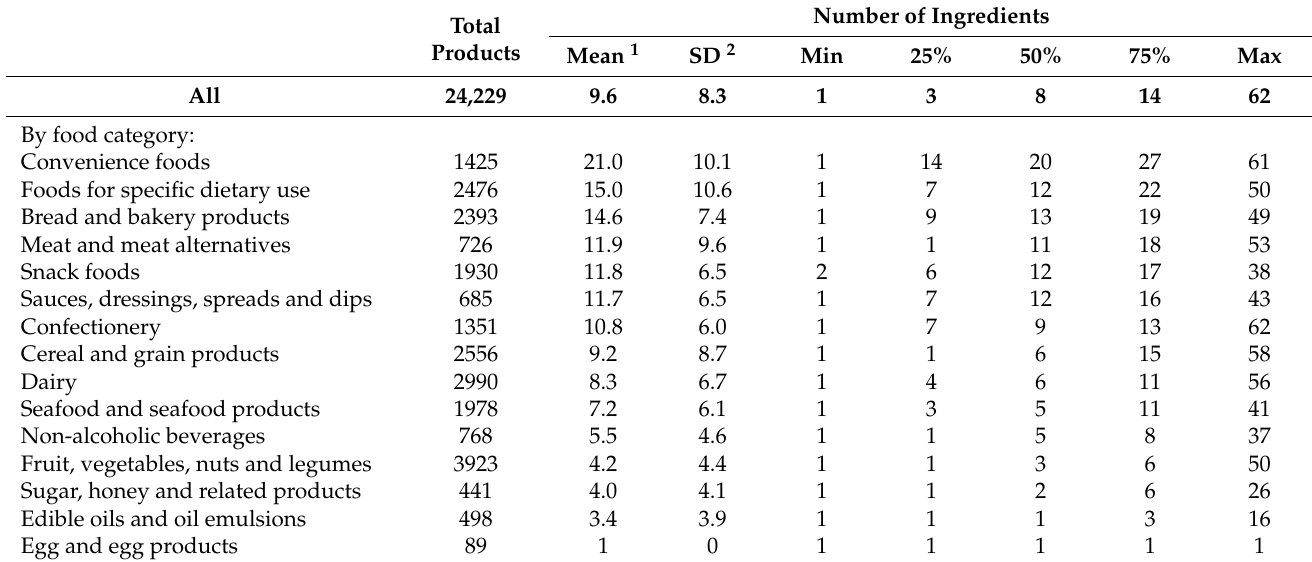
Figure 1. Distribution of the number of ingredients per product. The bar graph displays how many products contain the specified number of disaggregated ingredients in the statement of ingredients. The inset magnified graph displays the number of ingredients per product where product numbers are < 100. Table 3. The mean number and ranges of ingredients, overall and in major food